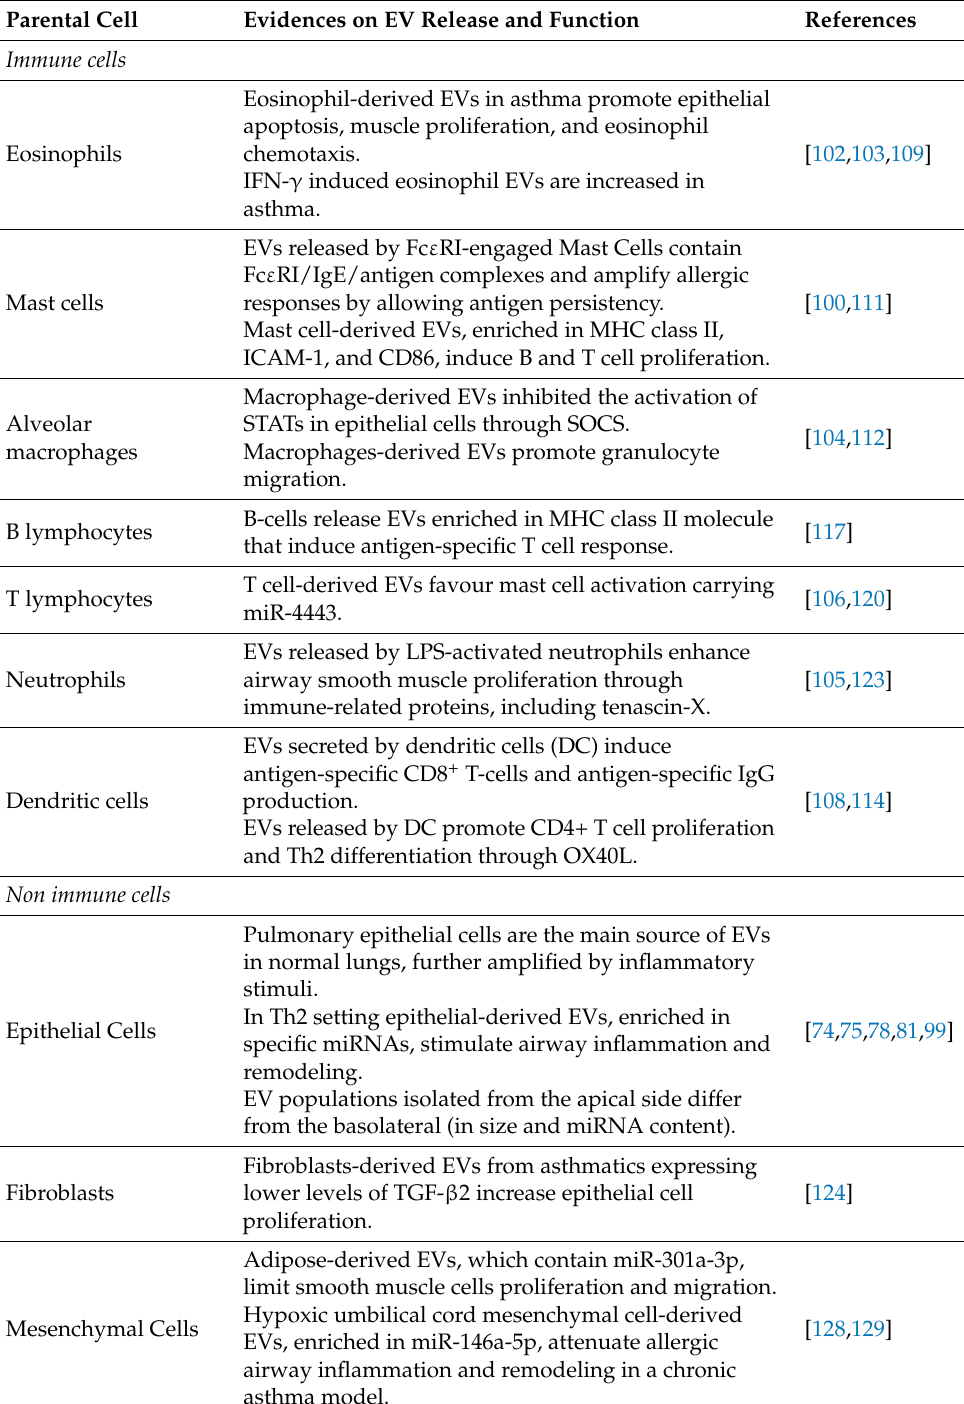
Table 1. Immune and non-immune cell-derived EVs and their functions in the context of asthma. Parental Cell Evidences on EV Release and